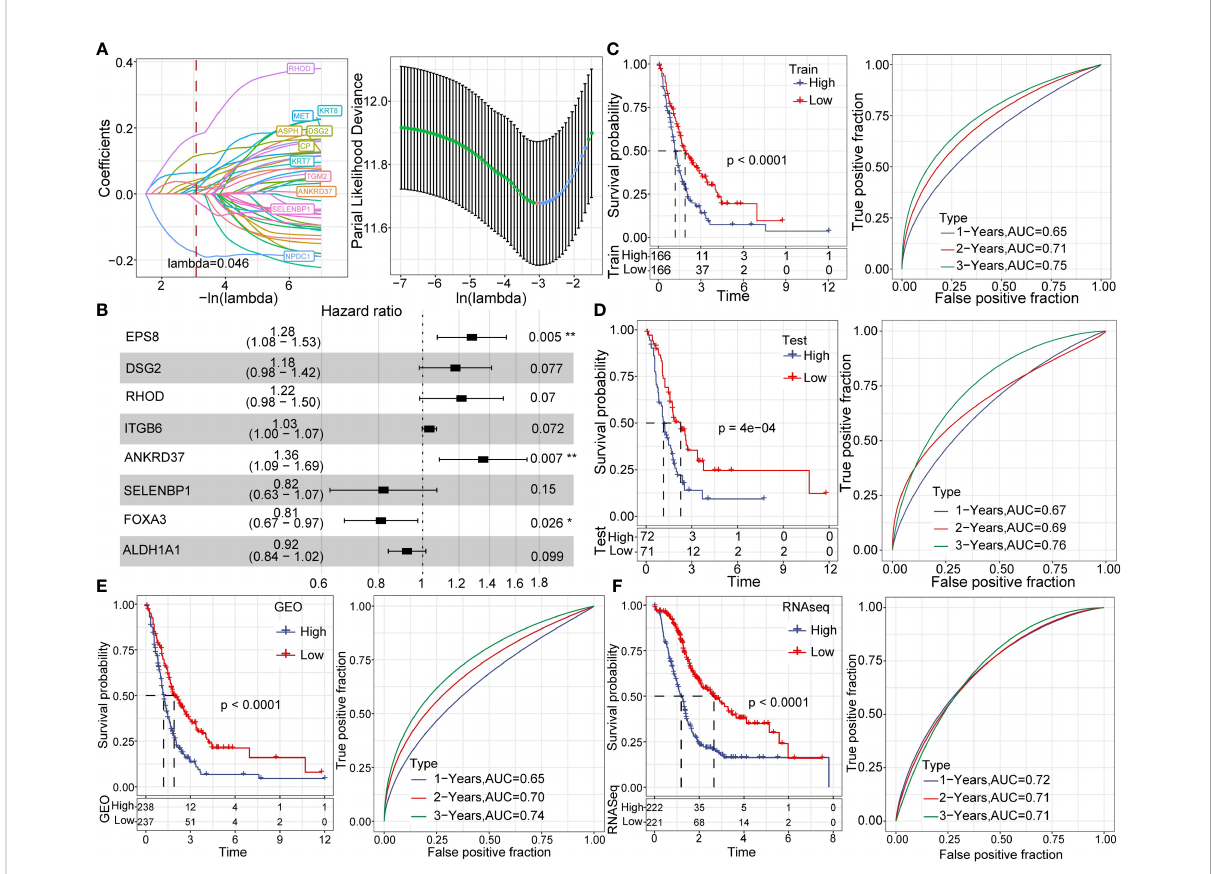
FIGURE 9 Establishment and analysis of prognostic models. (A) LASSO coef fi cient pro fi les of 42 prognostic genes in the GSE dataset. (B) Multivariate analysis of the risk model genes. (C) KM and ROC analysis of the risk model in the GEO dataset. (D) KM and ROC analysis of the risk model in the GEO validation dataset. (E) KM and ROC analysis of the risk model in the complete GEO dataset. (F) KM and ROC analysis of the risk model in complete the RNA-seq dataset. *p < 0.05; **p <